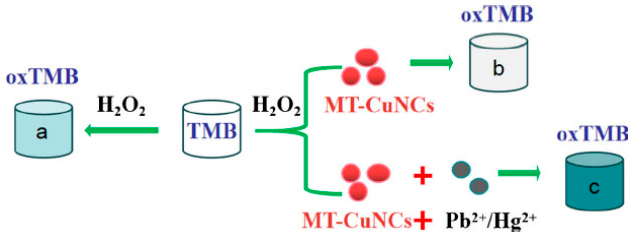
Figure 11. Oxidation of TMB by H 2 O 2 (product a), catalase-like activity of metallothionein-stabilised